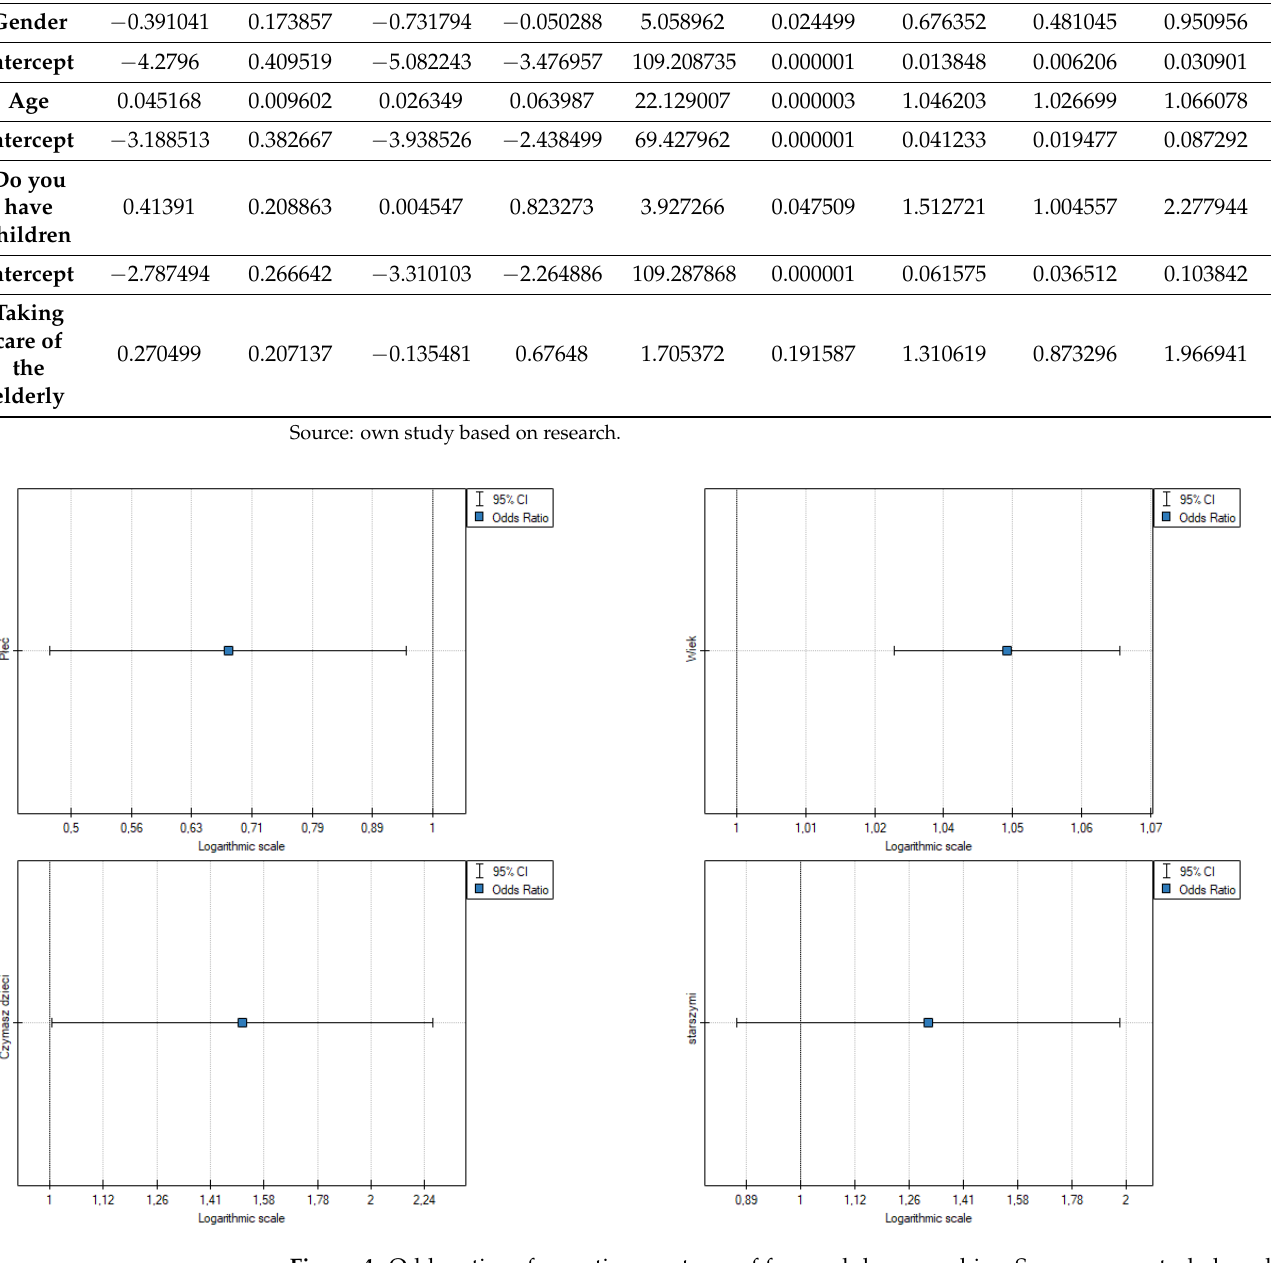
Figure 4. Odds ratios of somatic symptoms of fear and demographics. Source: own study based on research.